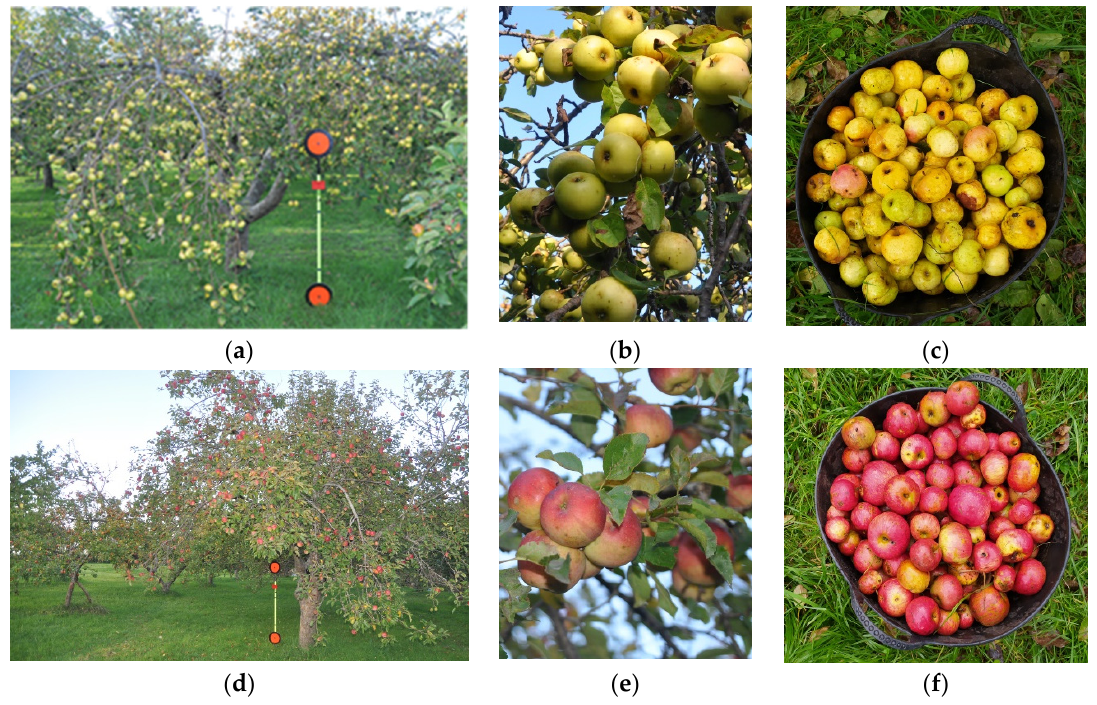
Figure 2. This figure shows the trees from which the samples were taken and their state of develop- ment in the different years: ( a – c ) Trees and fruits of apple variety “Blanquina”. ( d – f ) Trees and fruits of apple variety “Florina”.